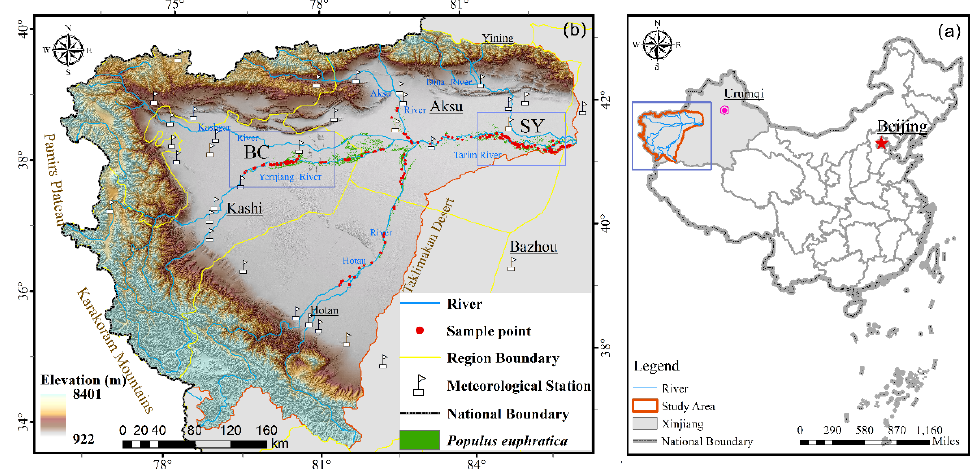
Figure 1. ( a ) Study area. ( b ) Sample points, meteorological stations, and typical sample area of Bachu (BC) and Saya (SY) regions.